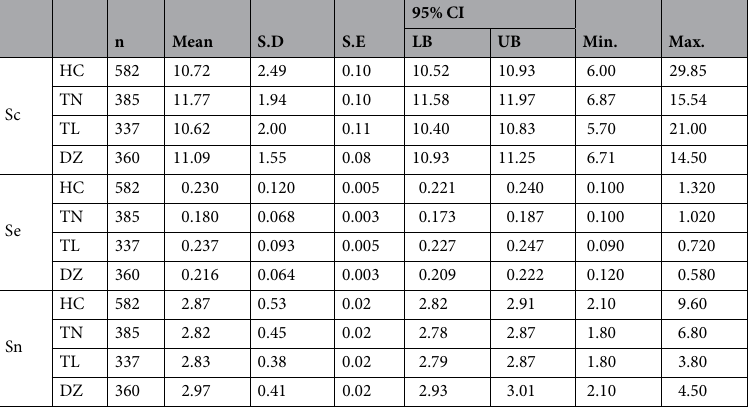
Table 1. Soil metal concentrations in four typical counties of Chongqing in the upper Yangtze Basin, China. S.D.- standard deviation. S.E.- Standard error. 95% CI-95% Confidence Interval for Mean. LB Lower Bound. UB Upper Bound. Min. Minimum. Max. Maximum.